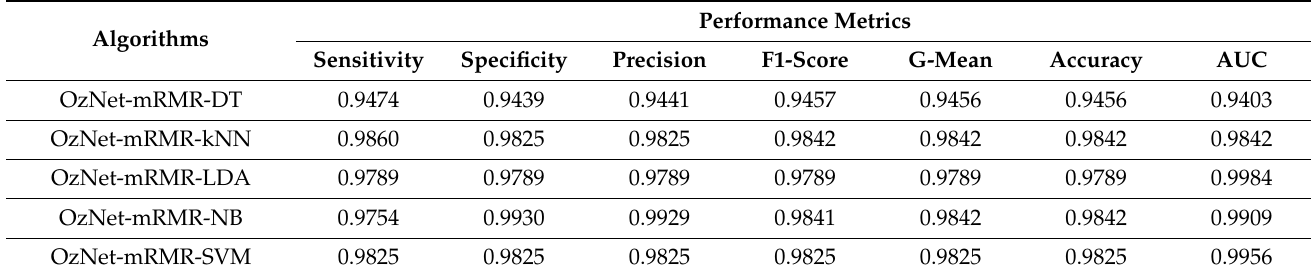
Table 5. Performance metrics of advanced hybrid algorithms on Brain Stroke CT images. Algorithms